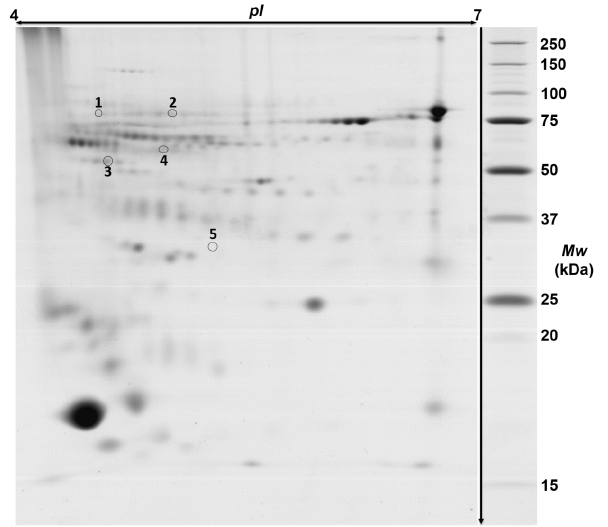
Figure 1. 2-DE map of the differentially abundant calves urine pro- teins. Presented 2-D gel was stained with Coomassie Brilliant Blue G-250; 100µg of proteins was applied on the IPG strip (7cm, pH 4– 7) for the first dimension, and the second dimension was performed on 12% SDS-PAGE gels. Spot numbers correspond to those in Ta- ble